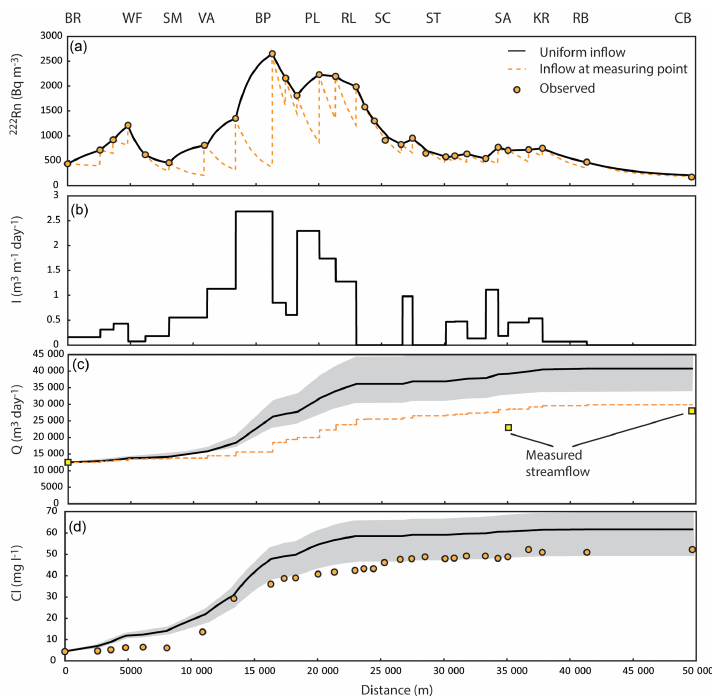
Figure 7. (a) Calculated vs. observed 222 Rn activities in the Avon River for February 2015 assuming both uniform groundwater inflow within each reach and the situation where groundwater inflow occurs immediately upstream of the measurement point. Site abbreviations are as for Fig. 2. (b) Calculated groundwater inflows ( I ) assuming uniform inflows within each reach. (c) Calculated increase in streamflow from groundwater inflows (Eq. 2). Both uniform groundwater inflow within each reach and the situation where groundwater enters the river immediately upstream of the measurement point overestimate the measured streamflow. Shaded area is the range of streamflow resulting from varying c gw within the 95% confidence interval. (d) Predicted vs. observed Cl concentrations. Shaded field is the range resulting from varying groundwater Cl concentrations within the 95% confidence